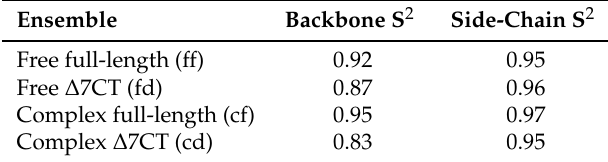
Figure 2. Measured (black) and back-calculated (colored according to key) backbone S 2 values for the ensembles. Table 1. Correlation of backbone and side-chain S 2 values in the calculated PDZ3